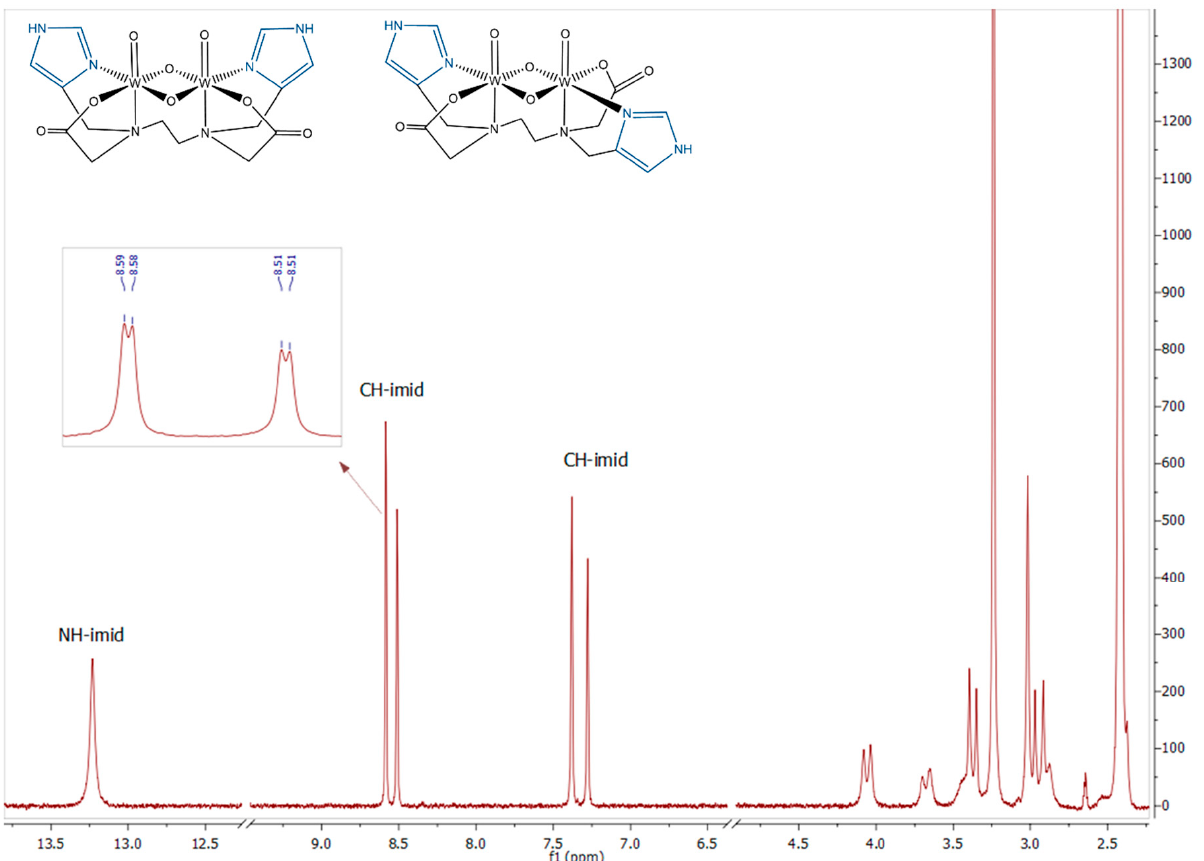
Figure 3. 1 H NMR spectra of [W 2 O 4 (L3)] ( 3 ) in DMSO-d 6 at RT; chemical formulae of two possible isomeric forms of the compounds are also shown. Peak assignment in the region below 4 ppm is difficult due to the several ethylene and methylene moieties presented in the molecule resulting in a complex pattern.